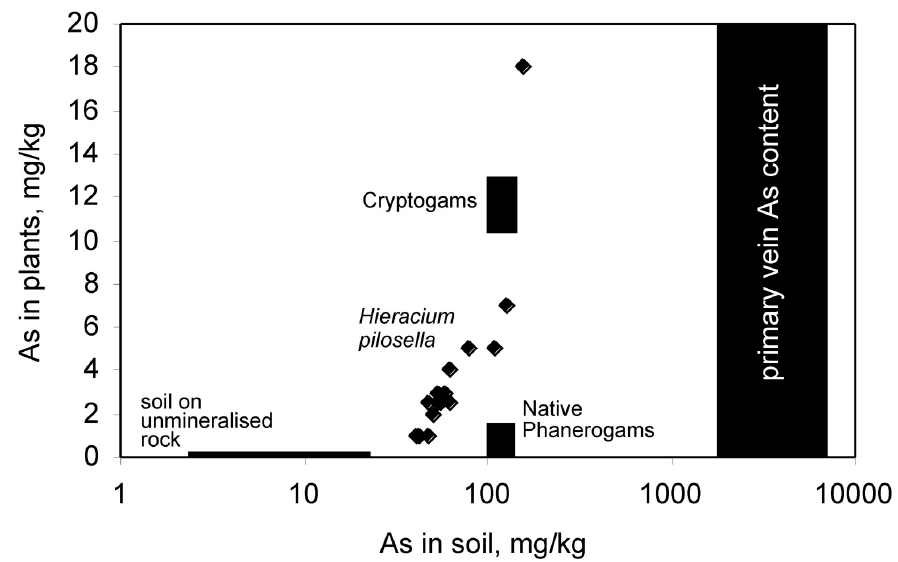
FIGURE 2. As contents of soils in the vicinity of a mineralised zone at Nenthorn (Fig. 1), and in plants from the same locality. As contents of background unmineralised soil (black line) and primary vein material (stippled) are indicated. NATURAL ARSENIC